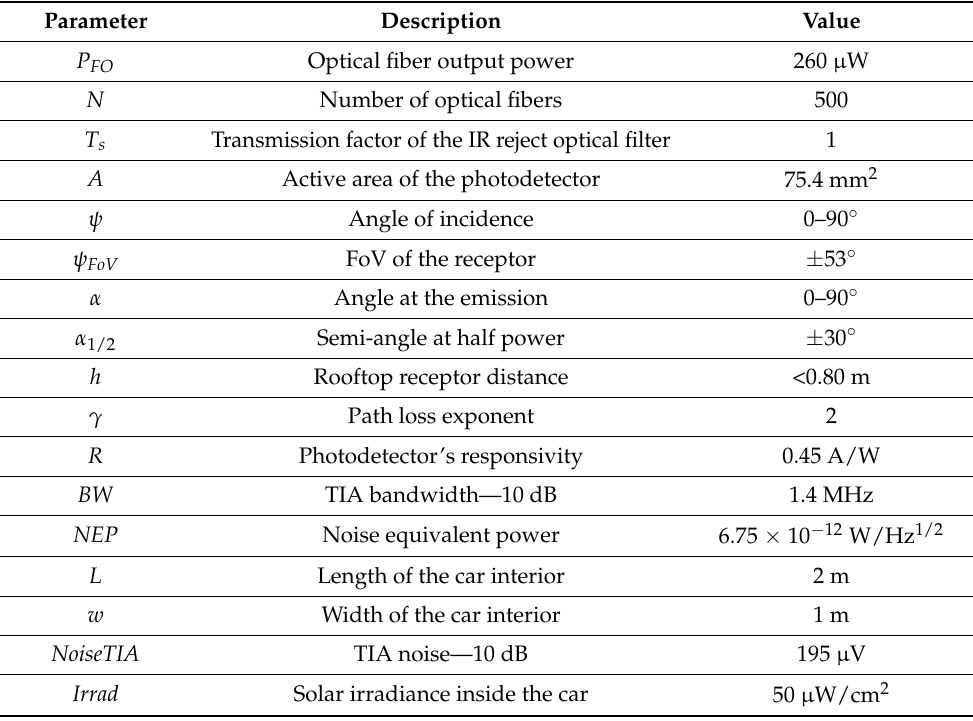
Table 4. Simulation parameters for the in-vehicle SNR distribution modeling.